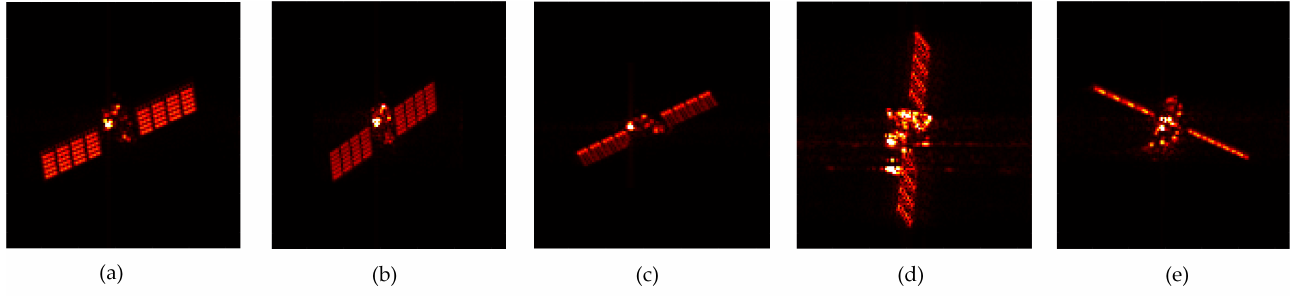
Figure 2. Various deformations of ISAR image for the same target. ( a ) Referenced ISAR image, ( b ) ISAR image azimuth scaling caused by accumulation angle, ( c ) ISAR image range scaling caused by radar bandwidth, ( d ) ISAR image rotation caused by target rotational motion, and ( e ) ISAR image deformation caused by the variation of main scattering centers.